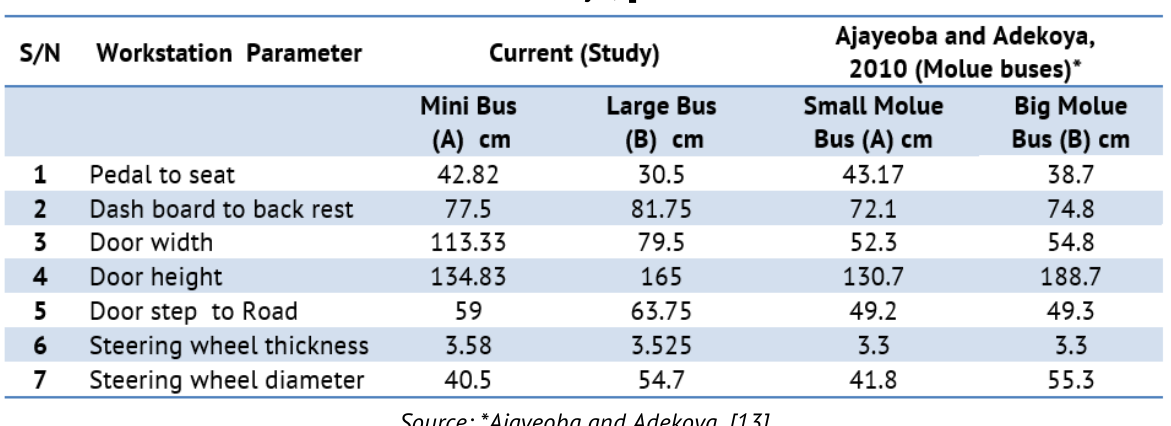
Comparison of Workstation Dimensions in this Study with Related Results by Ajayeoba and